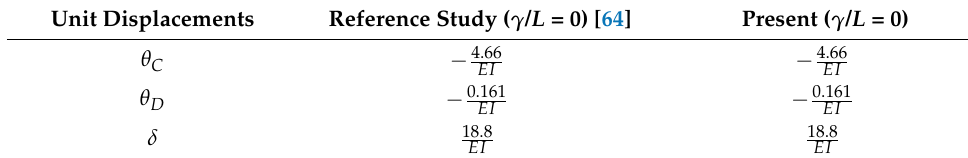
Table 2. Unit displacements for a frame system subjected to horizontal triangular load [64]. Unit Displacements